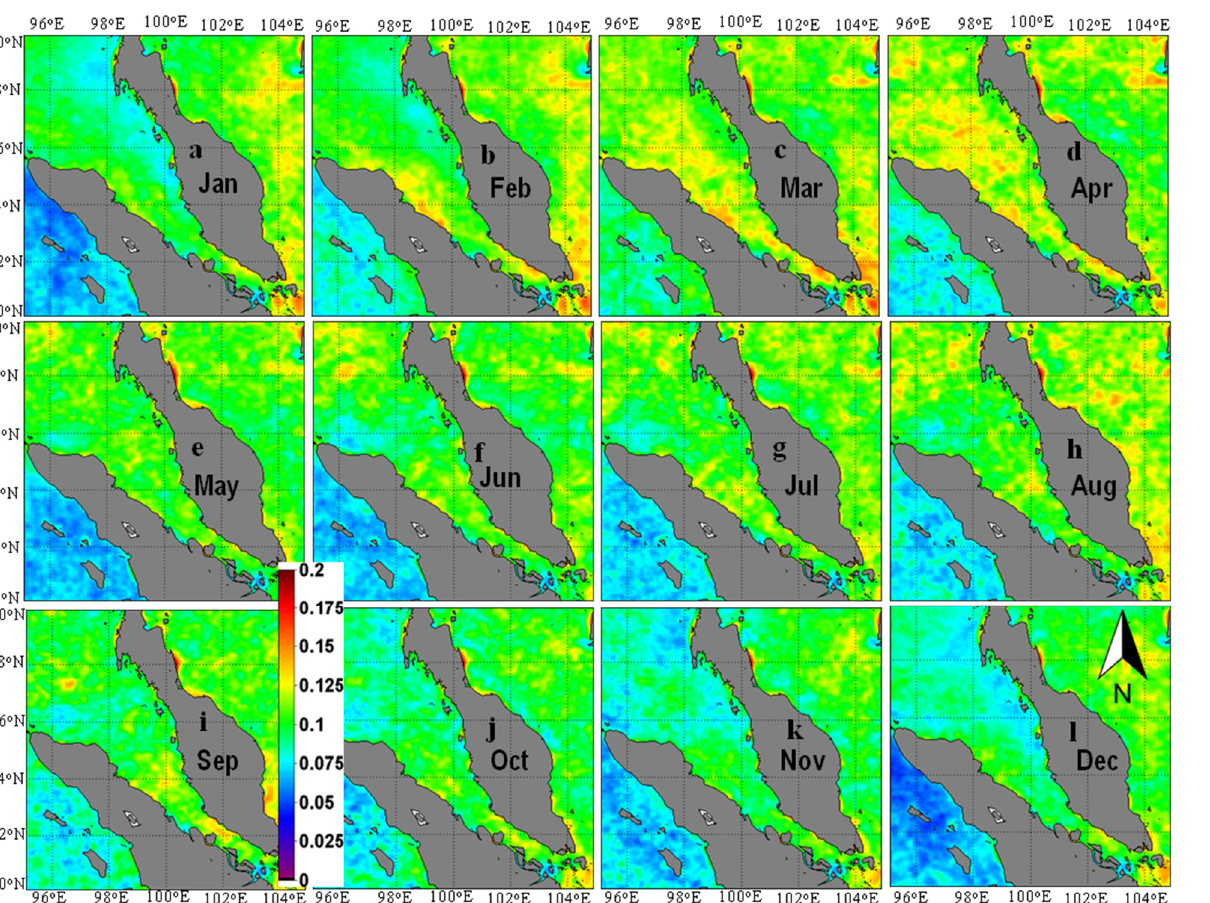
Figure 10. ( a – l ) Monthly climatological means of aerosol optical thickness (AOT) averaged from monthly SeaWiFS AOT retrieved within the period of the SeaWiFS full